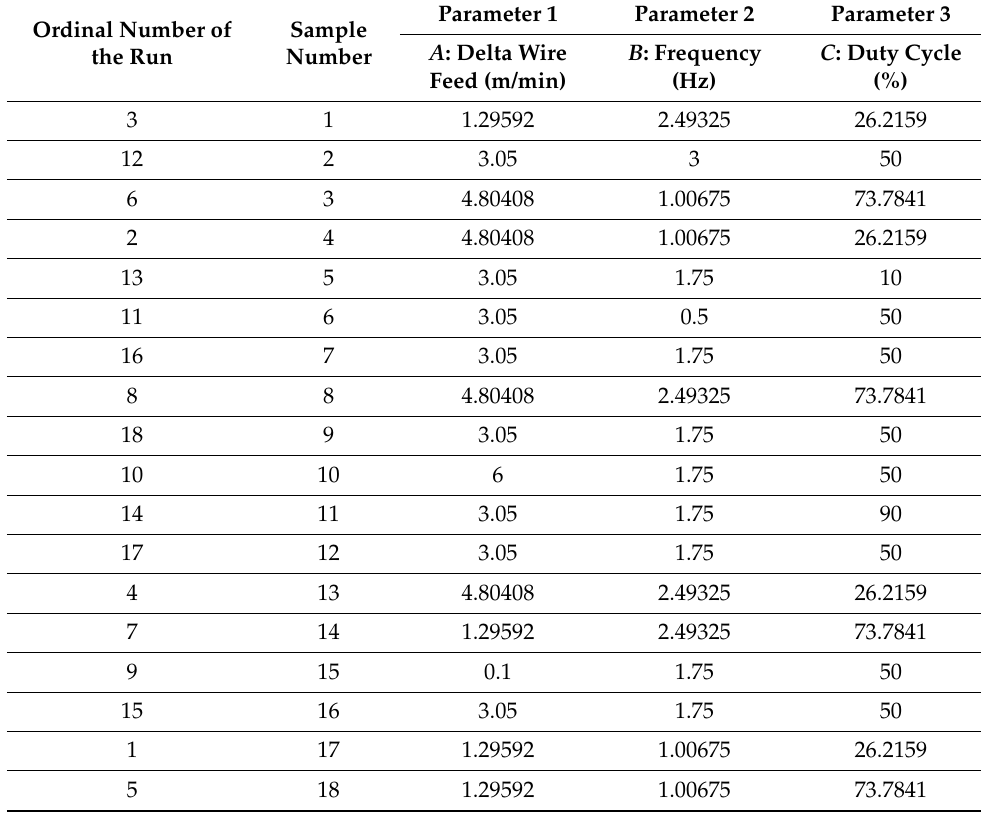
Table 5. Overview of values referring to input variables as determined by Design Expert software (Minneapolis, MN,